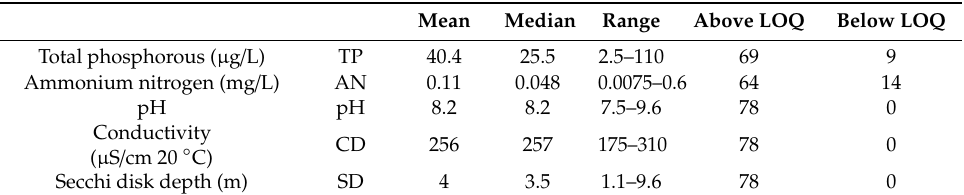
Table A3. List of water surface physical–chemical variables selected for the final MLR analysis. For each physical–chemical variable, the mean, median, range, and number of measurements above/below the level of quantification (LOQ) are reported.